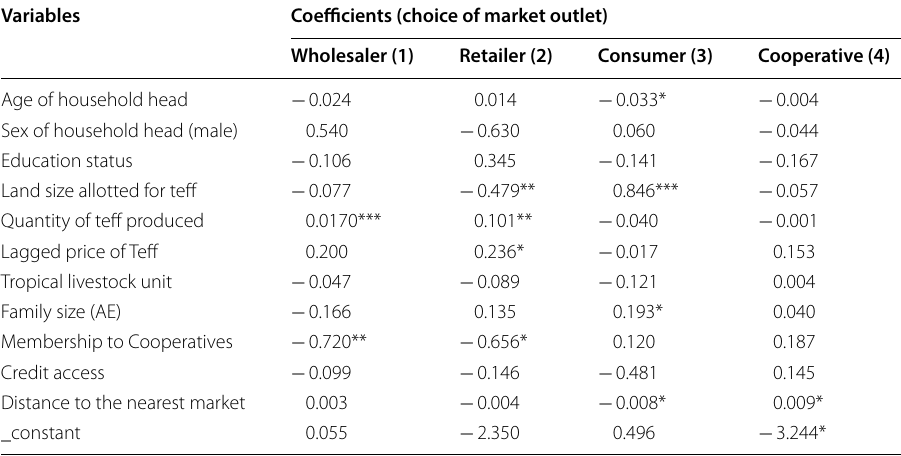
Dependent variable market outlet choices; ***, ** and * are statistically significant at 1%, 5% and 10% significance level,